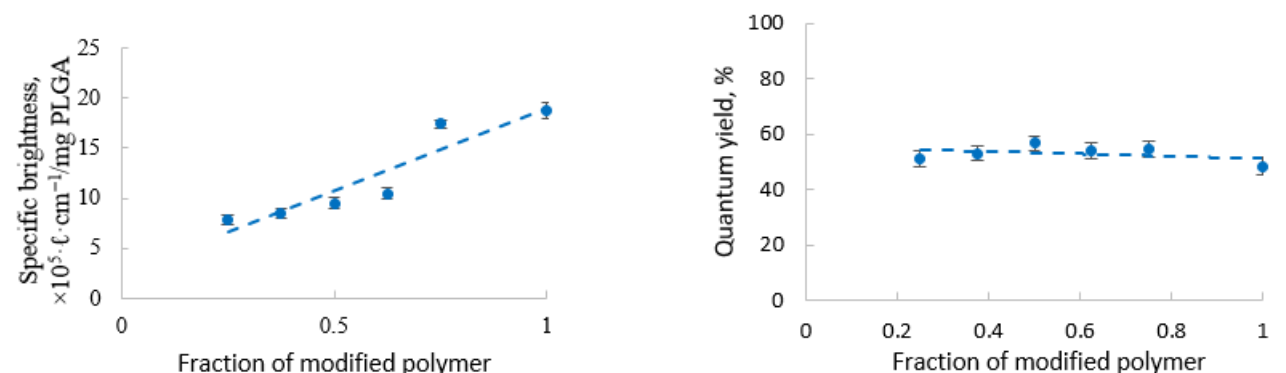
Figure 4. Influence of the PLGA-Cy5.5 content in nanoparticles on brightness ( left ) and quantum yield ( right ). As shown in Figure 5, the PEG-PLGA-Cou6 nanoparticles were by far the brightest among the single-labeled nanoparticles.